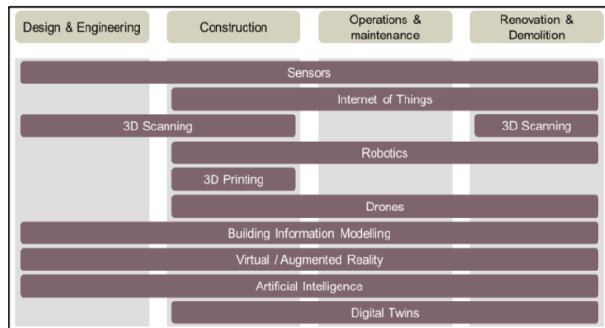
Figure 2 . The use of digital technologies in various SDL phases (EC,